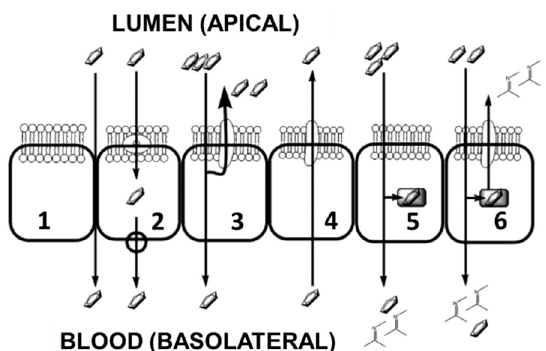
Figure 1. Graphical representation of the six epithelial transport characteristics for the uptake of cytotoxic compounds from oral administration, adapted from Chan et al. [37]. 1 — Paracellular absorption via the interstitial spaces between cells, this is restricted by intercellular tight junctions. 2 — Transport mechanisms at either the apical or the basolateral membranes. 3 — Restriction of transport into the blood flow by apical membrane efflux transporters. 4 — Efflux membrane transporters enabling clearance of compounds from the blood. 5 — Metabolism of compounds prior to transport to the blood. 6 — Co-ordination of metabolizing enzymes and apical efflux transporters forming an intestinal absorption barrier.